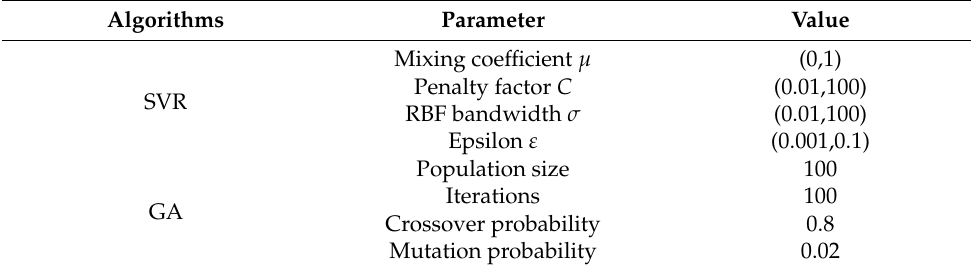
Table 2. Parameters of SVR and